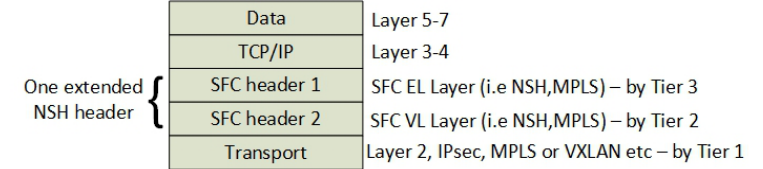
Figure 6. Additional Service Function Chaining layer.